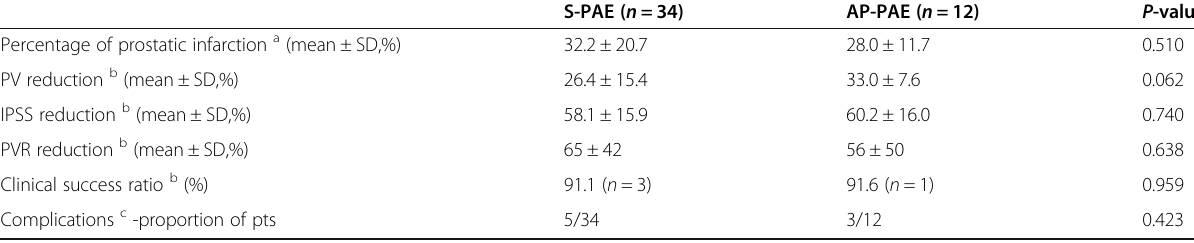
S-PAE ( n = 34) P -value